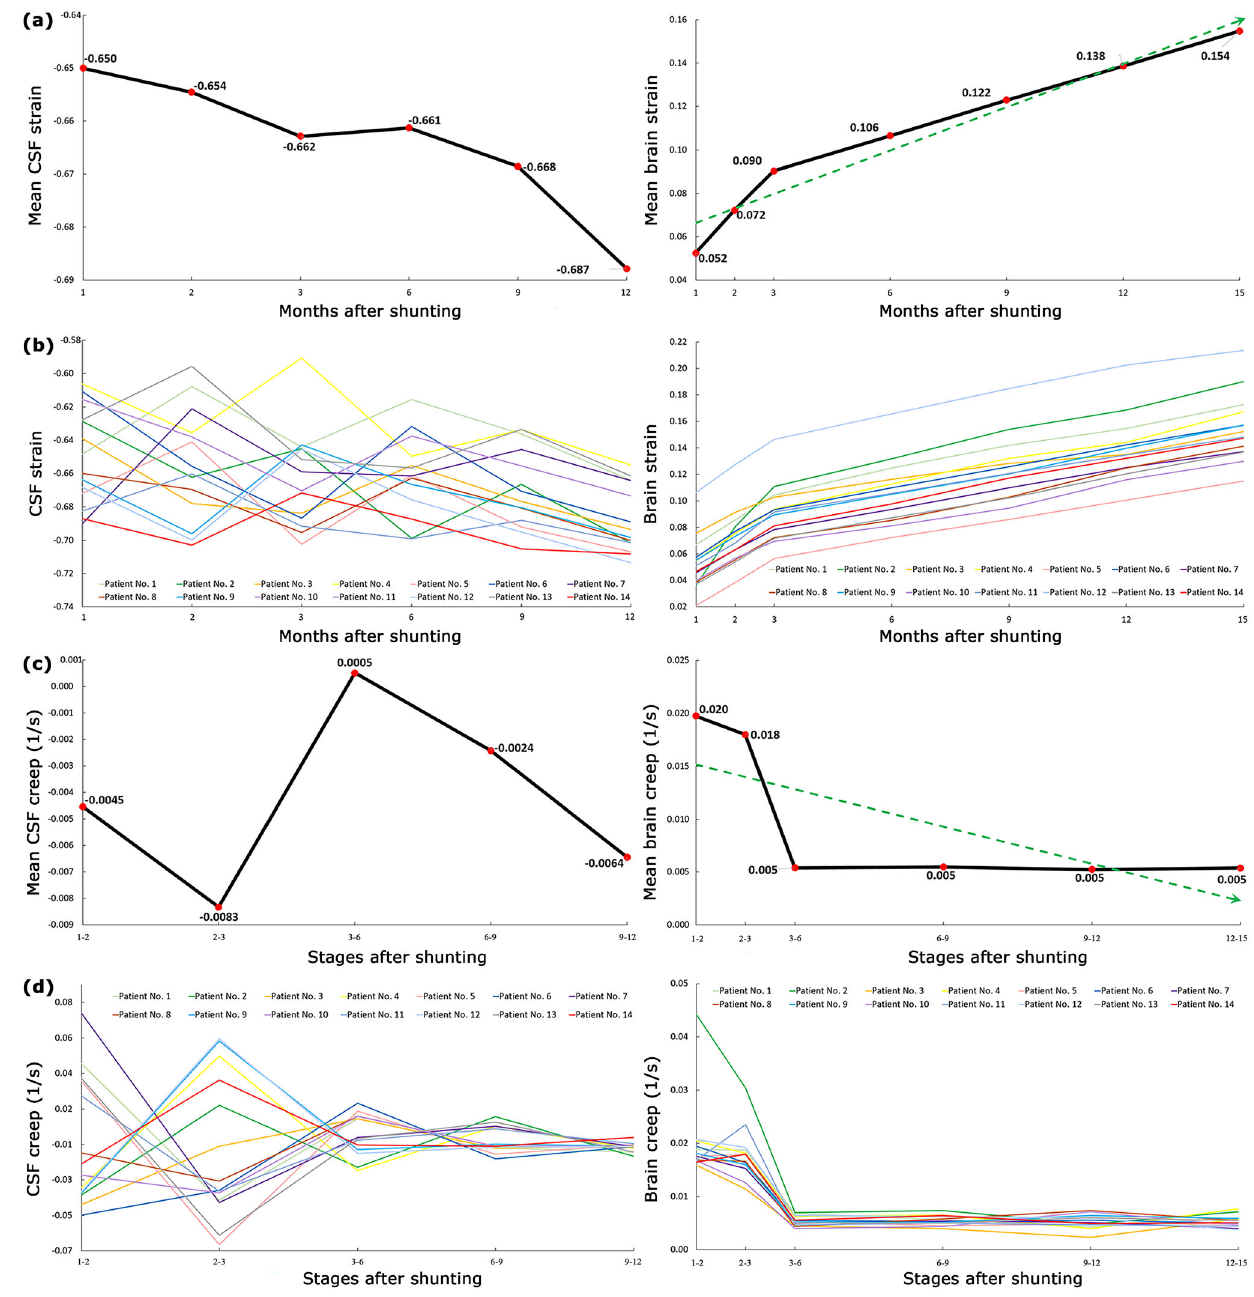
Fig. 3 Changes in strain and creep of CSF and brain after shunting. a Mean CSF and brain strain. b CSF and brain strain of all patients until 15 after shunting. c Mean CSF and brain creep. d CSF and brain creep of all patients until 15 after shunting. CSF volume changes after the twelfth month were negligible, hence, CSF strain and creep values after the twelfth month were not calculated. The reason for the negative values of CSF strain is the descending trend of CSF volume changes after shunting. “ Stages 1 – 2 ” means the CSF volumetric creep between the fi rst and second months after shunting. Raw data for Fig. 3 is included in Supplementary Tables 2 – 5. CSF Cerebrospinal fl